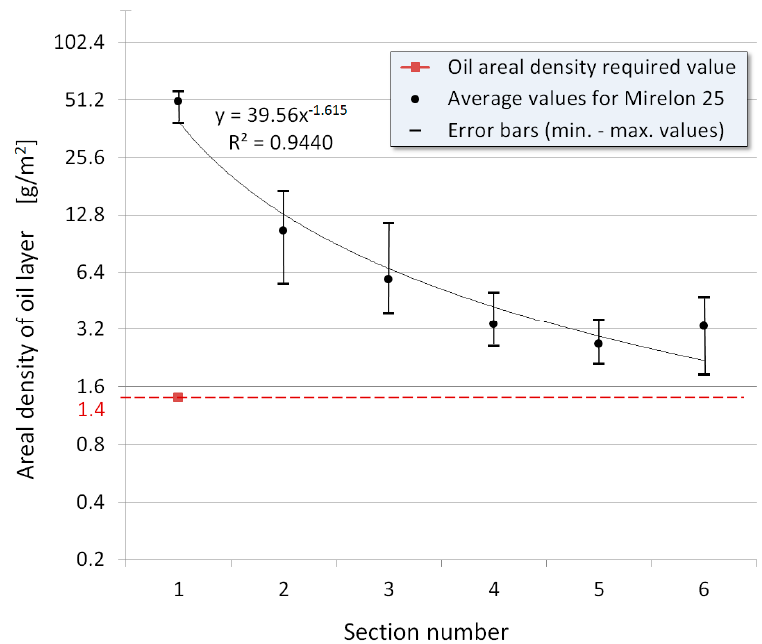
Figure 18. Graphical representation of average oil film weights in individual sections of coated Mirelon 25 pipes. Data is downloaded from Table 2.